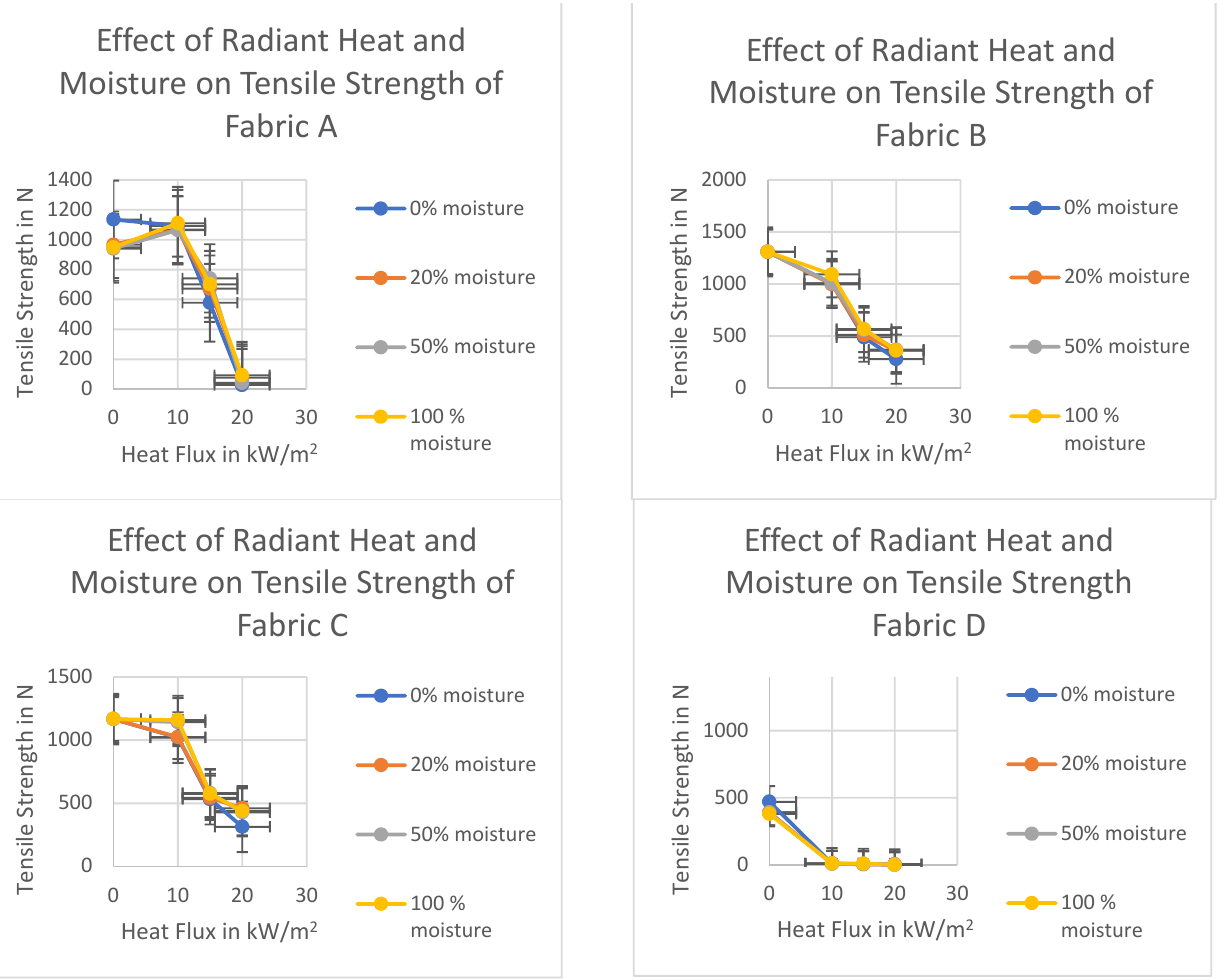
Figure 7. Effect of moisture and radiant heat on tensile strength of fabrics in single layer fabric system. Table 5. Statistical analysis of single layer fabric system in presence of